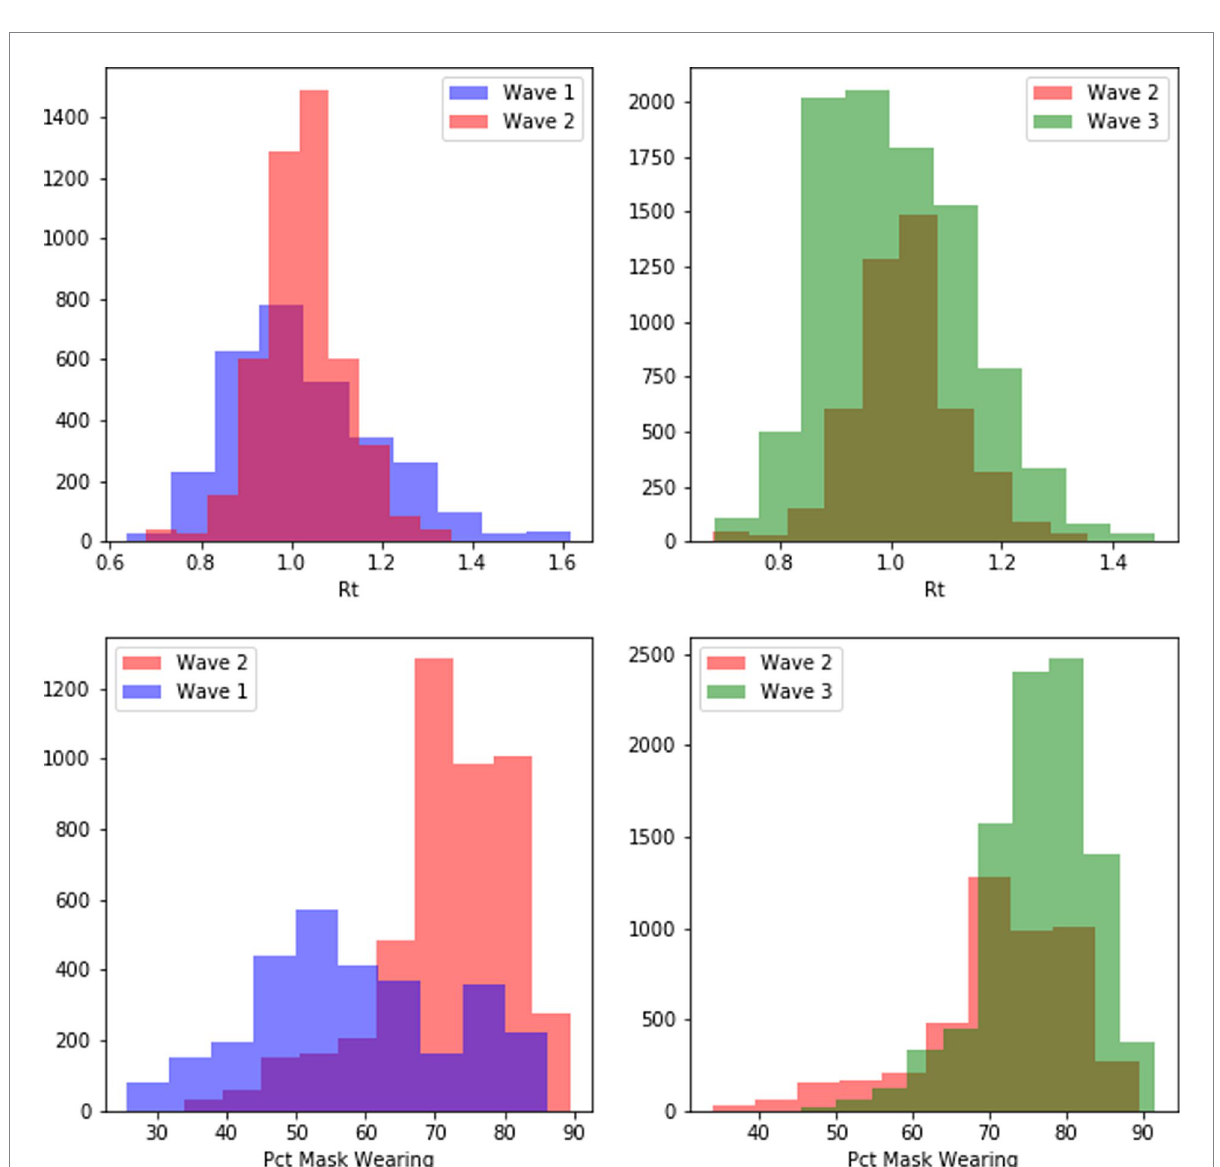
FIGURE 12 Distribution of effective transmission number over three waves of COVID-19 in the United States (top) and the shift of mask-wearing rates over the same three waves (bottom).